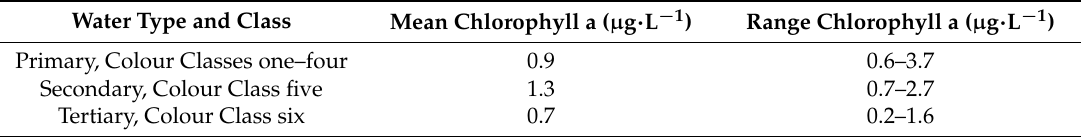
Table 1. Chlorophyll a concentrations in the different water types and colour